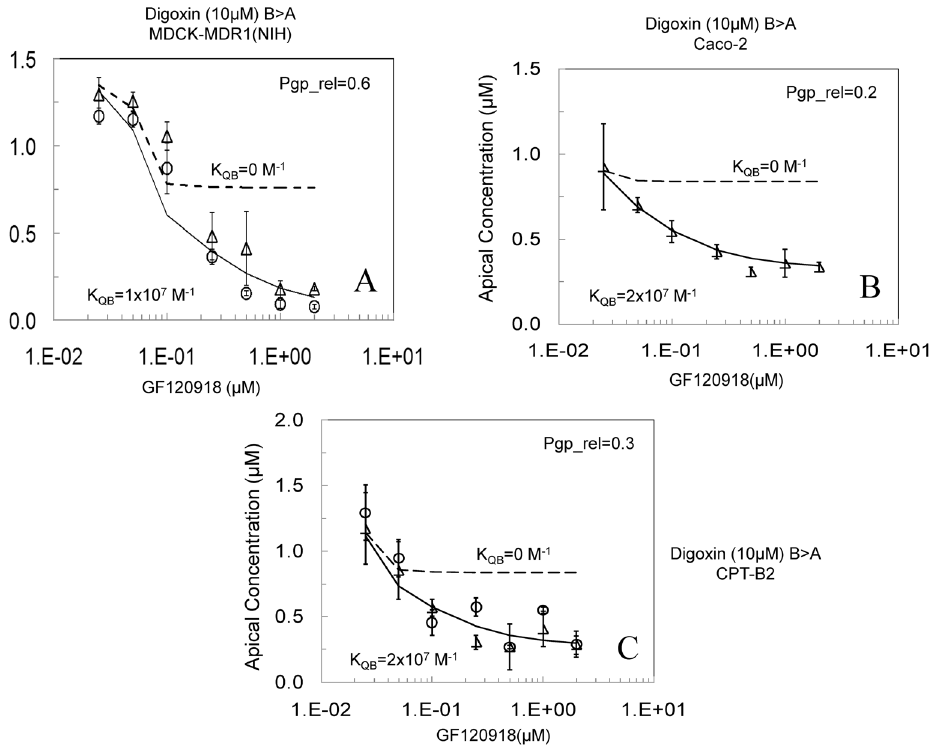
Figure 5. Inhibition of 10 m M digoxin B . A transport across cell monolayers, as measured on the apical side after 1 hr with increasing concentrations of GF120918 using the MDCK-MDR1-NIH cell monolayers (Fig. 5A), Caco-2 monolayers (Fig. 5B), and CPT-B2 monolayers (Fig. 5C), data acquired at Absorption Systems. Open symbols represent experimental data sets. The dotted lines shows the fitted inhibition assuming that the inhibitor binds only to P-gp, i.e. K QB =0. The solid lines show the fit using the values of K QB shown in Table 3.